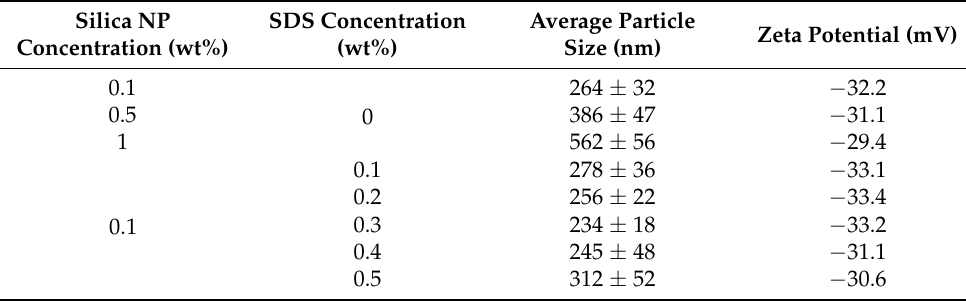
Table 1. Average particle size and zeta potential of nanofluid